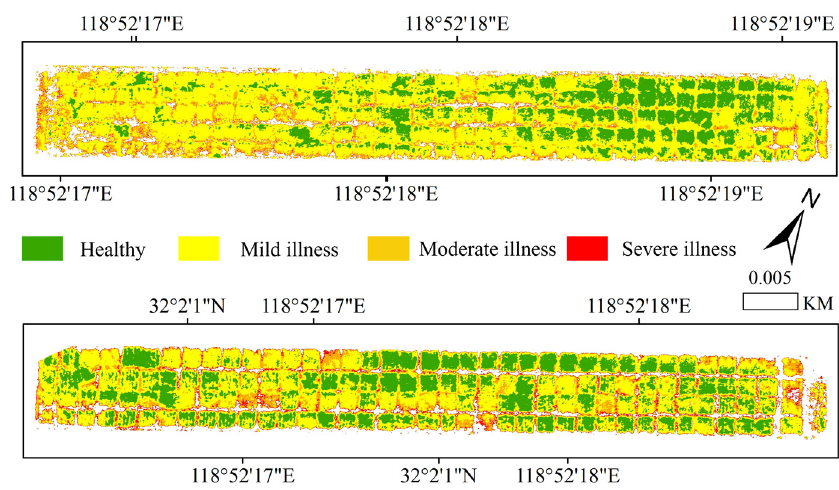
Figure 8. Distribution map of wheat scab in the study